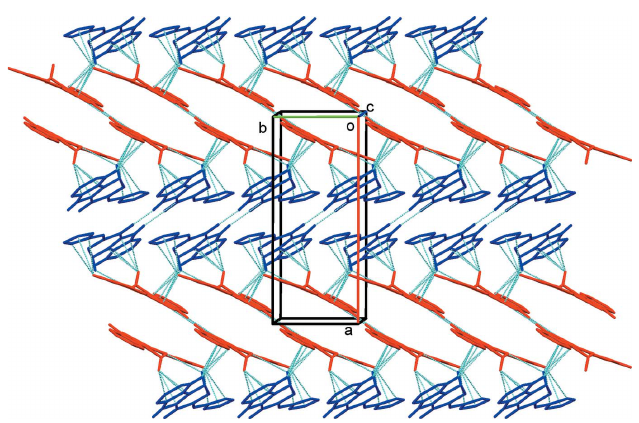
Figure 4 Crystal packing of the title compound, viewed along the c axis, showing the N—H (cid:2)(cid:2)(cid:2) O hydrogen bonds and C—H (cid:2)(cid:2)(cid:2) (cid:2) interactions (blue dashed lines; see Table 1). Only the H atoms involved in these interactions have been included; A molecules are blue and B molecules are red.